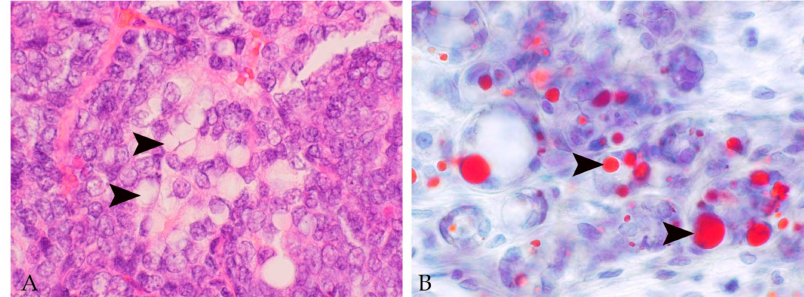
Figure 2. Microscopic images of rabbit mammary gland adenocarcinoma. ( A ) Adenocarcinoma with moderate numbers of tumor cells that contain well-demarcated empty vacuoles (arrowheads) (hematoxylin–eosin stain). ( B ) The Sudan-red stain on a cryostat section confirms that the vacuoles in tumor cells are lipid droplets